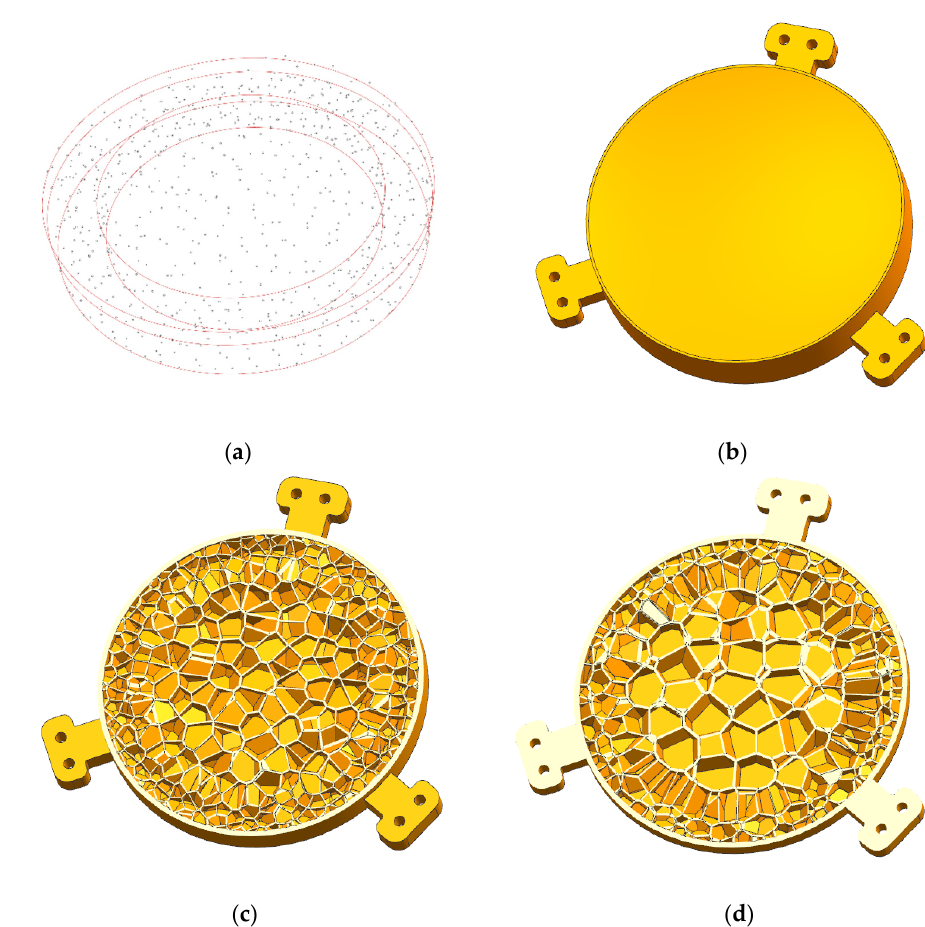
Figure 8. ( a ) Seed distribution of 2.5D-Voronoi mirror; ( b ) 2.5D-Voronoi mirror; and ( c ) half-cutaway view of 2.5D-Voronoi mirror.